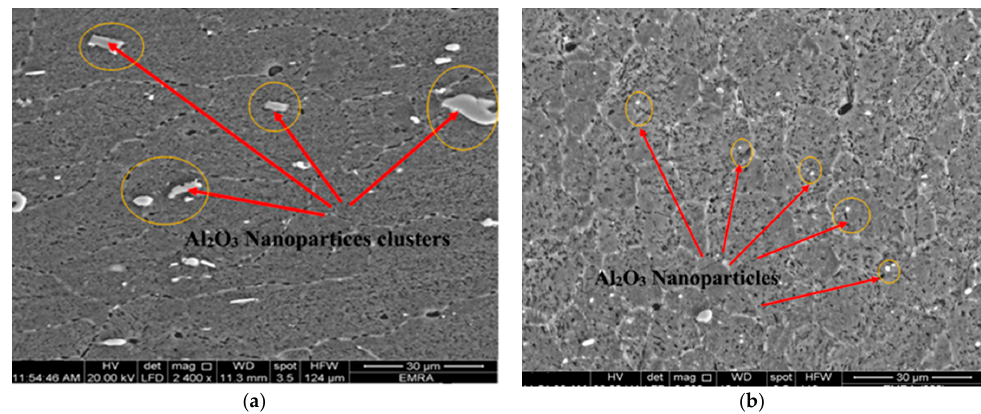
Figure 12. Scanning electron micrograph of Al 2 O 3 nanoparticle clusters in the composite matrix performed in ( a ) the first pass at 1120 rpm at 15 mm/min; ( b ) the first pass at 1120 rpm at 15 mm/min. Materials 2017 , 10 , 1053